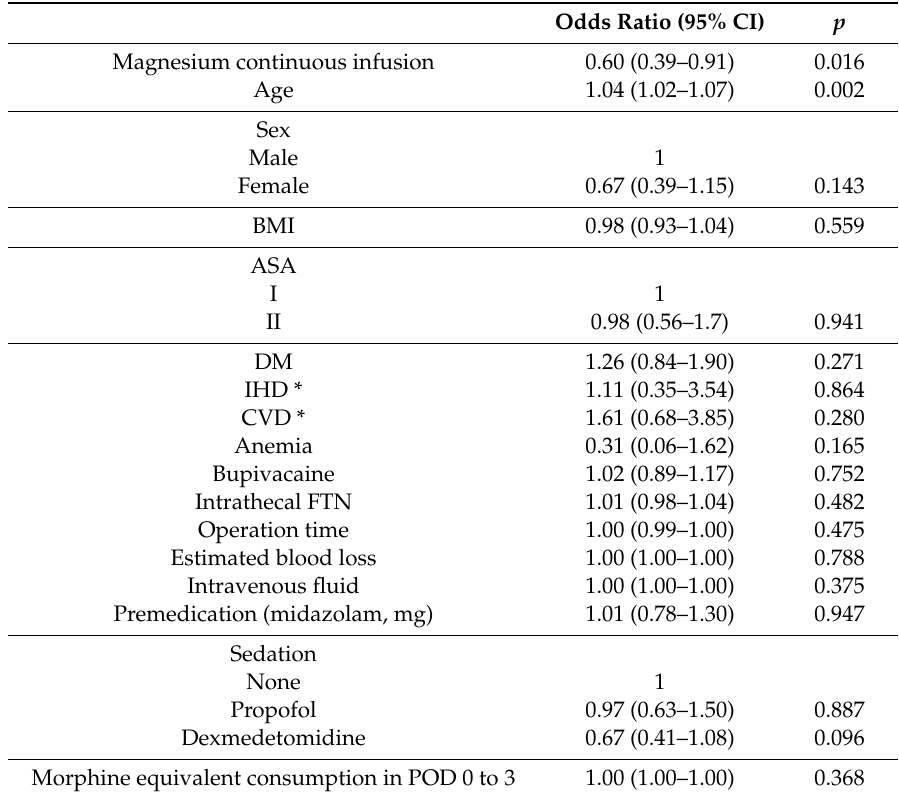
Table 3. Results of univariate analysis of variables associated with urinary